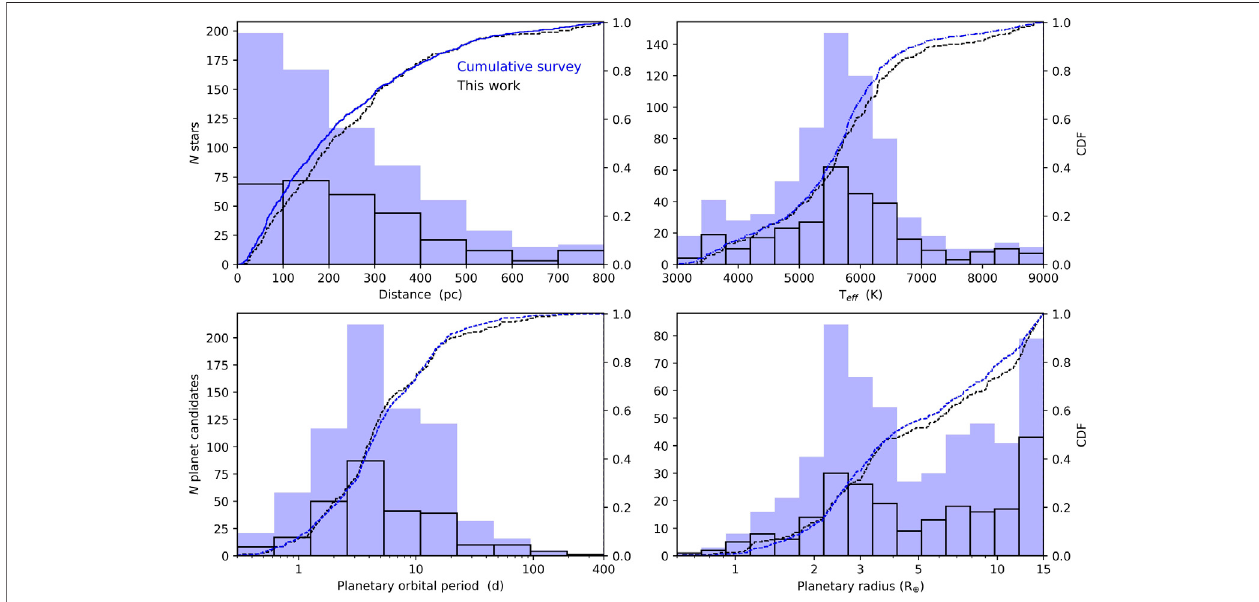
FIGURE 3 | The properties of the 653 TESS planet candidate hosts observed in the SOAR TESS survey from Ziegler et al., (2020) and in preparation (this work). A cumulative density function for each property is overplotted in black. Targets identi fi ed as known or likely false positives, 196 in total, have been removed.